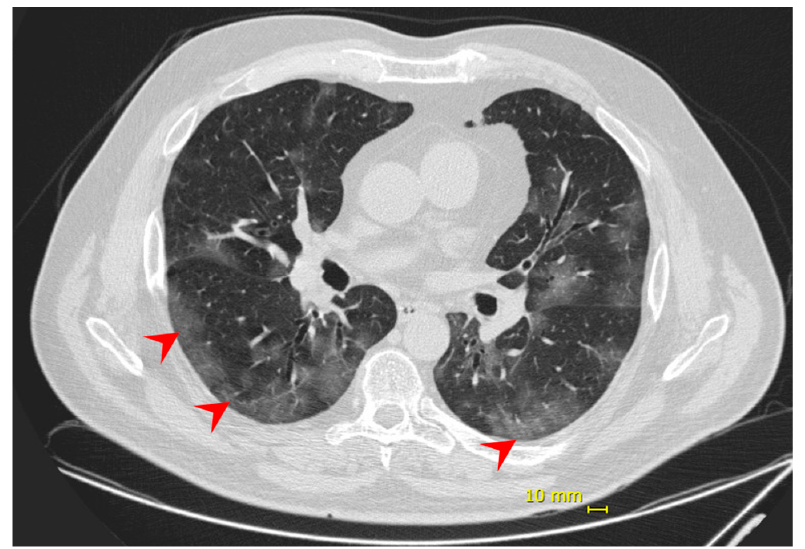
Figure 1. Patient 1—chest computed tomography evidenced bilateral multifocal ground-glass opacities (25–50%) predominantly peripheral (red arrow).